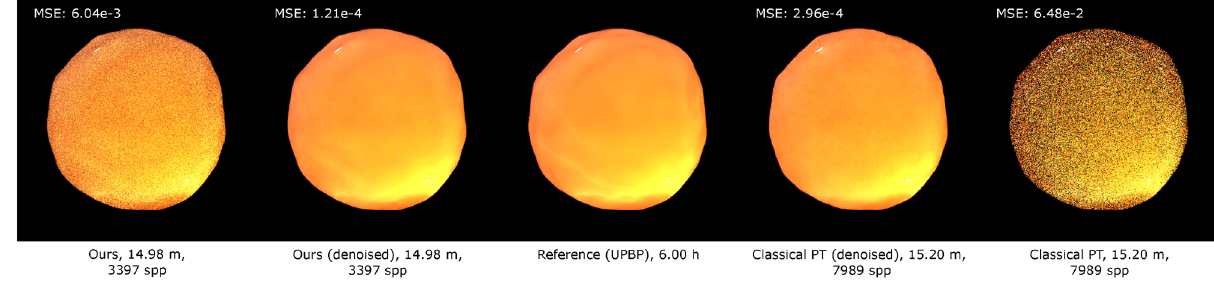
Fig. 11 Comparison of our method and path tracing with equal time for the Bumpy Sphere scene (full solution).